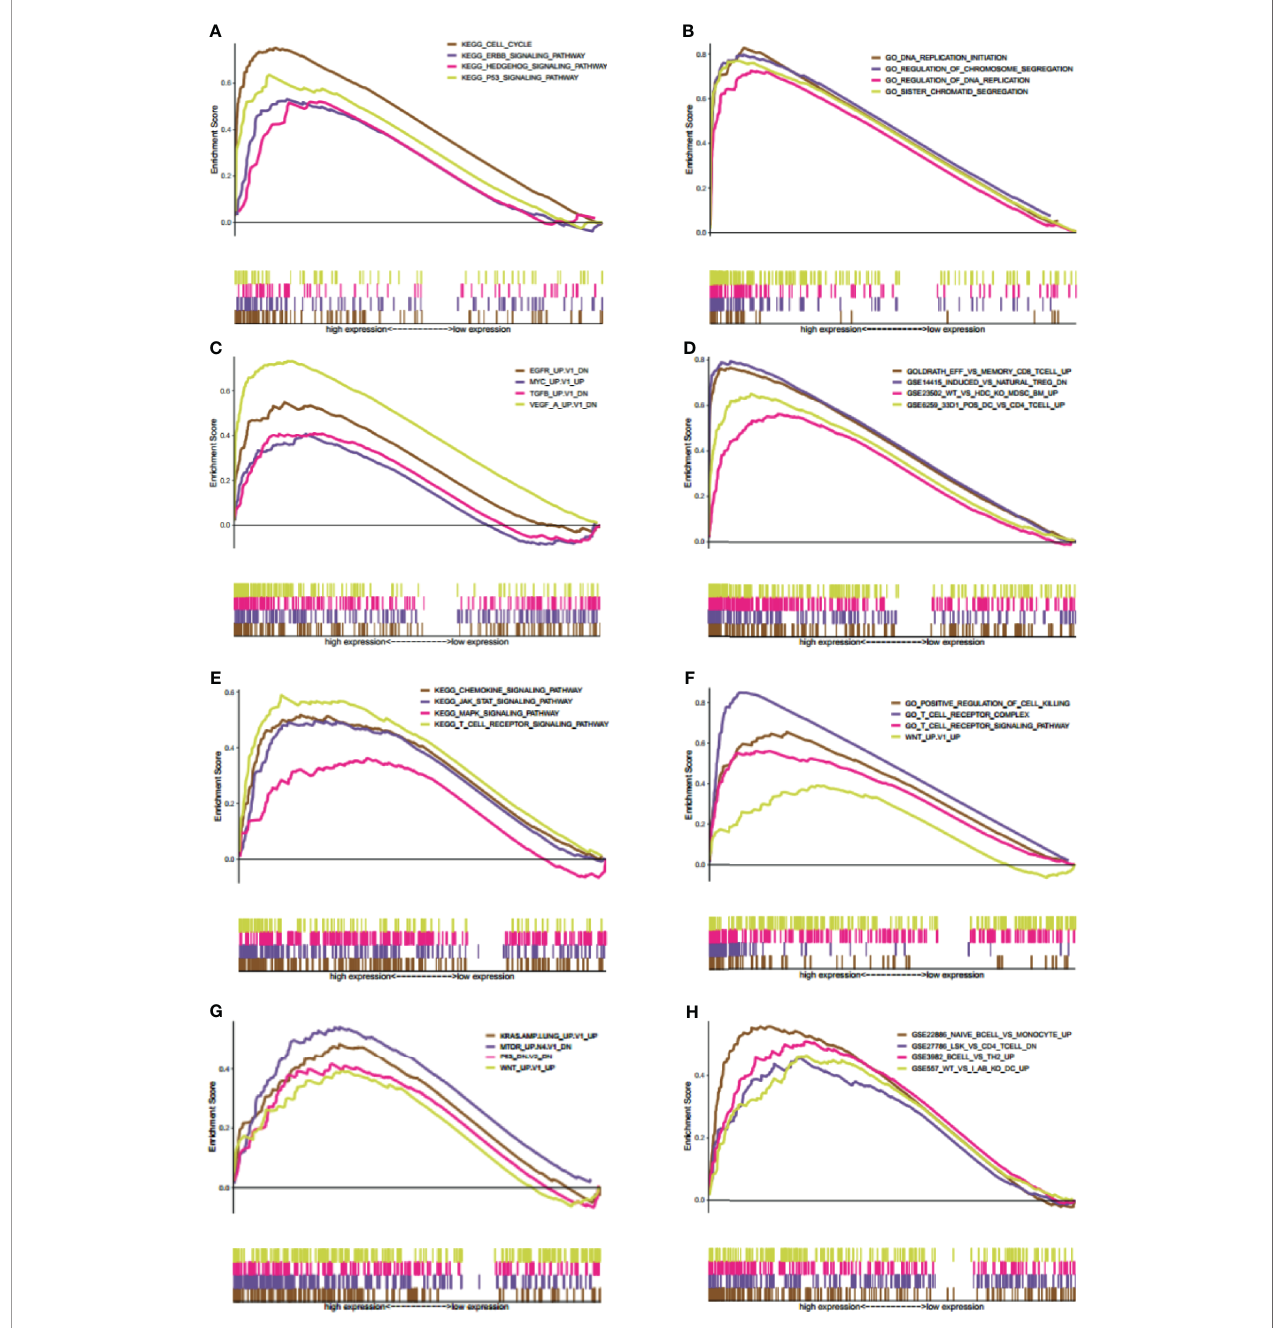
FIGURE 12 | Gene set enrichment analysis (GSEA) of both KIF20B and KIF21B. (A – D) GSEA results of KIF20B expression in PC patients ( A – D presents C2, C5, C6, C7 MSigDB respectively). (E – H) denote the GSEA of KIF21B (E – H) presents C2, C5, C6, C7 MSigDB respectively). The MsigDB C2, C5, C6, C7 were used to explore the oncogenic and immunologic roles of KIF20B and KIF21B. The GSEA results indicated that KIF20B and KIF21B were signi fi cantly enriched in oncogenic and immunologic